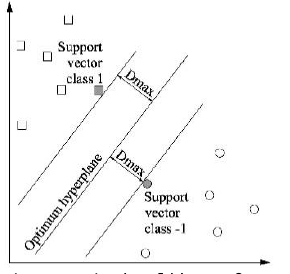
Figure 2. Separation margin should be as far as possible of the hardest classification cases (support vectors) Source: Authors,